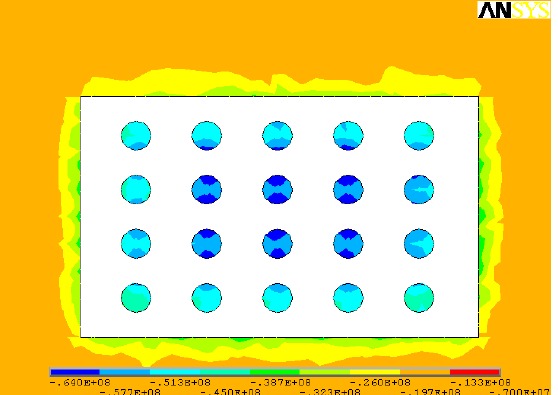
Figure 21. Minimum principal stress distribution of scheme 2 pillars at 1480 mL (parameters of scheme 2: stope height 2.5 m, pillar diameter 3 m, pillar spacing 6 m, pillar row spacing 8 m).